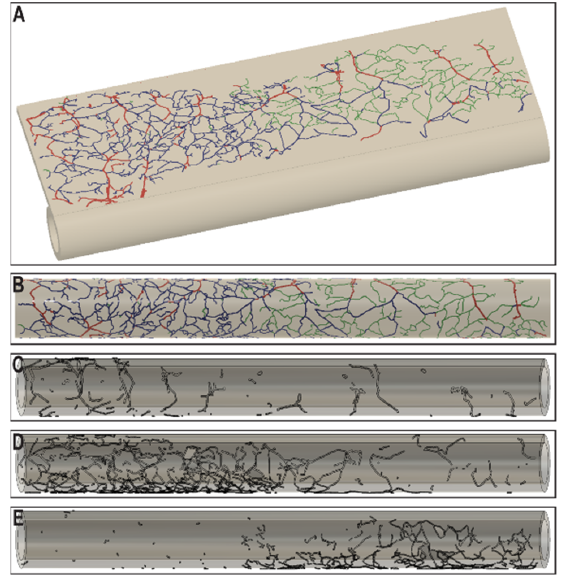
Figure 5. Cylindrical conversion of the colon image for printing. ( A ) Flat image from Figure 3 with the three separated branch generations in colors, displayed as prepared for rolling on a cylinder (inclined presentation to provide additional perspective). ( B ) Cylinder ‐ rolled image of the vascular pattern. ( C – E ) Rolled monocolor rendering of the .stl files of separated images of each vascular branch generation.